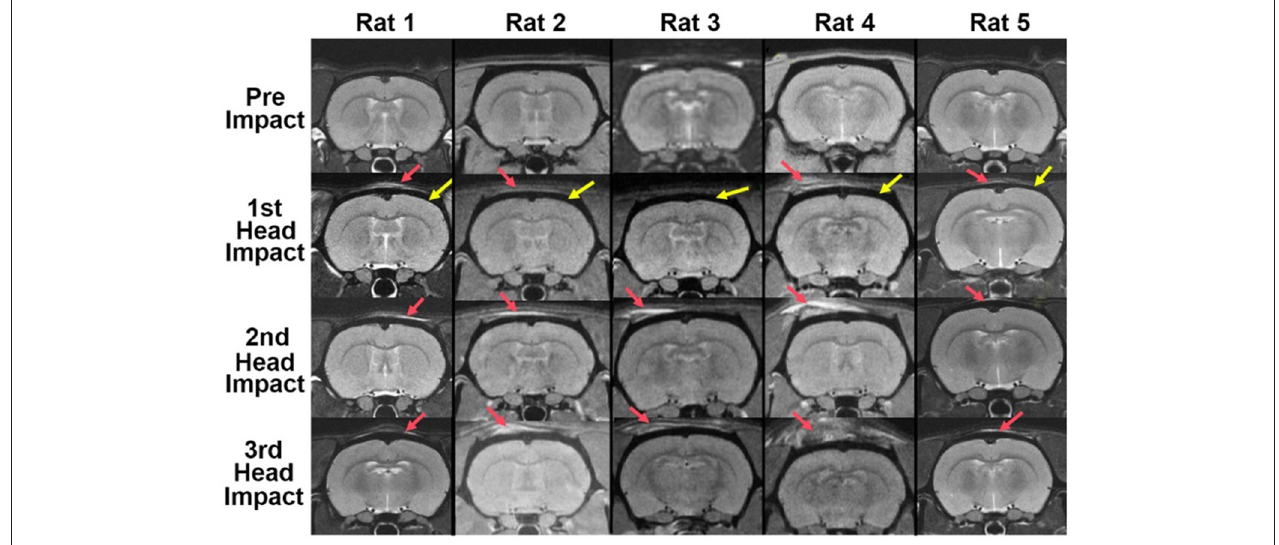
FIGURE 1 | Brain neuroanatomy following repetitive mild head impacts. Mild head impact without evidence of brain damage. Shown are axial sections of T2-weighted anatomical images taken within 1h of mild head impact. The site of impact noted by the red arrow can be identified by the high intensity signal reflecting the edema on the tissue. The yellow arrows point to the black contour of the cranium. There is no visible evidence of structural brain damage.